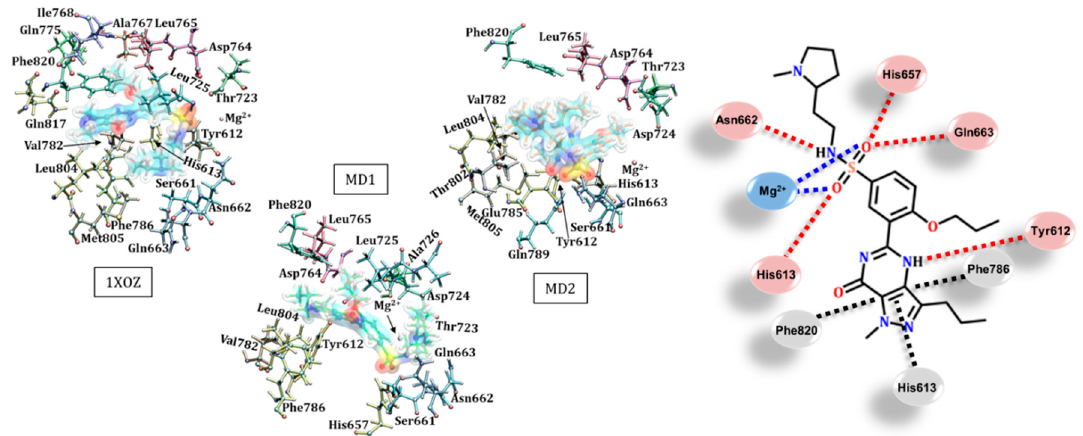
Figure 5. Interactions between protein–udenafil in the catalytic site of PDE5 for crystallographic structure 1XOZ, MD1 and MD2. Di ff erent arrangements of the ligand in each structure and some important interactions are highlighted at the right. Residues were r ≤ 3.0 Å from the ligand. Legend of interactions, red: hydrogen bond (and dipole–dipole); black: π -stacking; blue: metal–ligand.